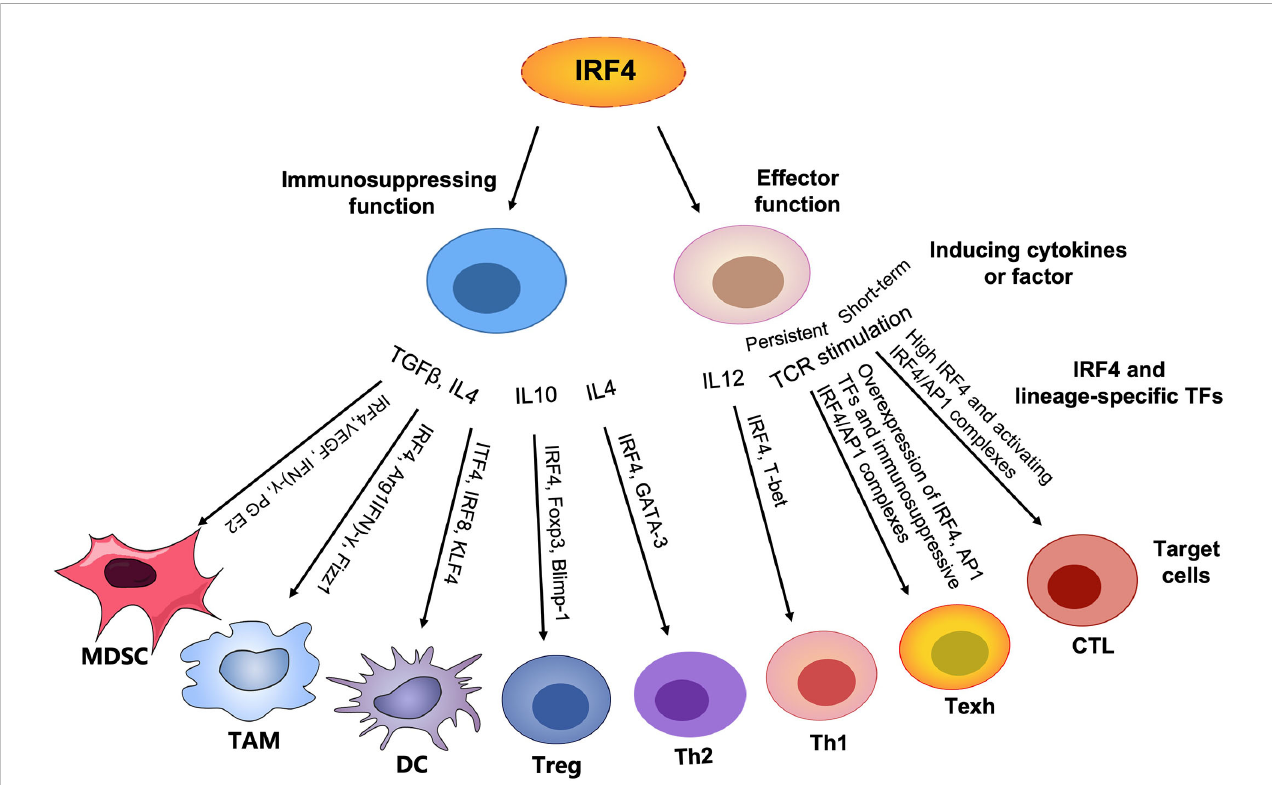
FIGURE 1 Graphical abstract. In contrast to lineage-speci fi c TFs, IRF4 plays an important role in T cell differentiation and function by regulating the expression of corresponding transcription factors (TFs) to control the generation of other lineages, particularly the differentiation and proliferation of effector T cells, promoting anti-tumor immunity. However, persistently high expression of IRF4 and AP1 family members leads to overabundance of IRF4/AP1 complexes to drive T cell exhaustion. In addition, IRF4 plays an important role in the development and function of a series of immunosuppressive cells, such as MDSCs, TAMs, immature DCs, Treg cells and Th2 cells, maintaining immune homeostasis and in parallel establishing an immunosuppressive TME and inhibiting anti-tumor